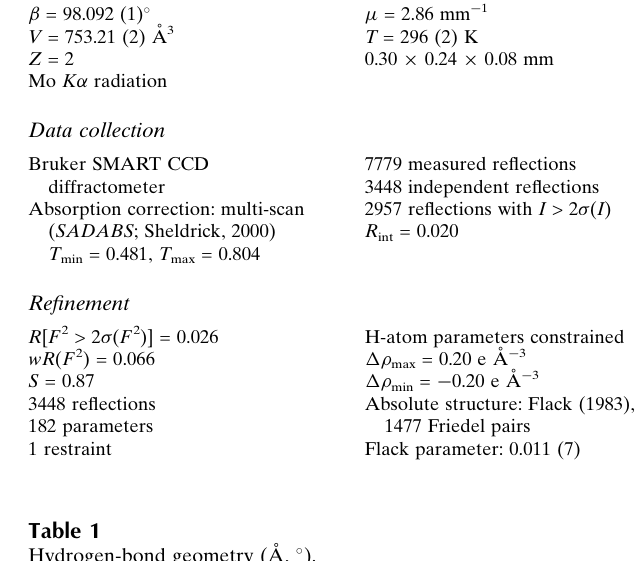
Hydrogen-bond geometry (A˚ , (cid:1) ). D —H (cid:2)(cid:2)(cid:2) A D —H H (cid:2)(cid:2)(cid:2) A